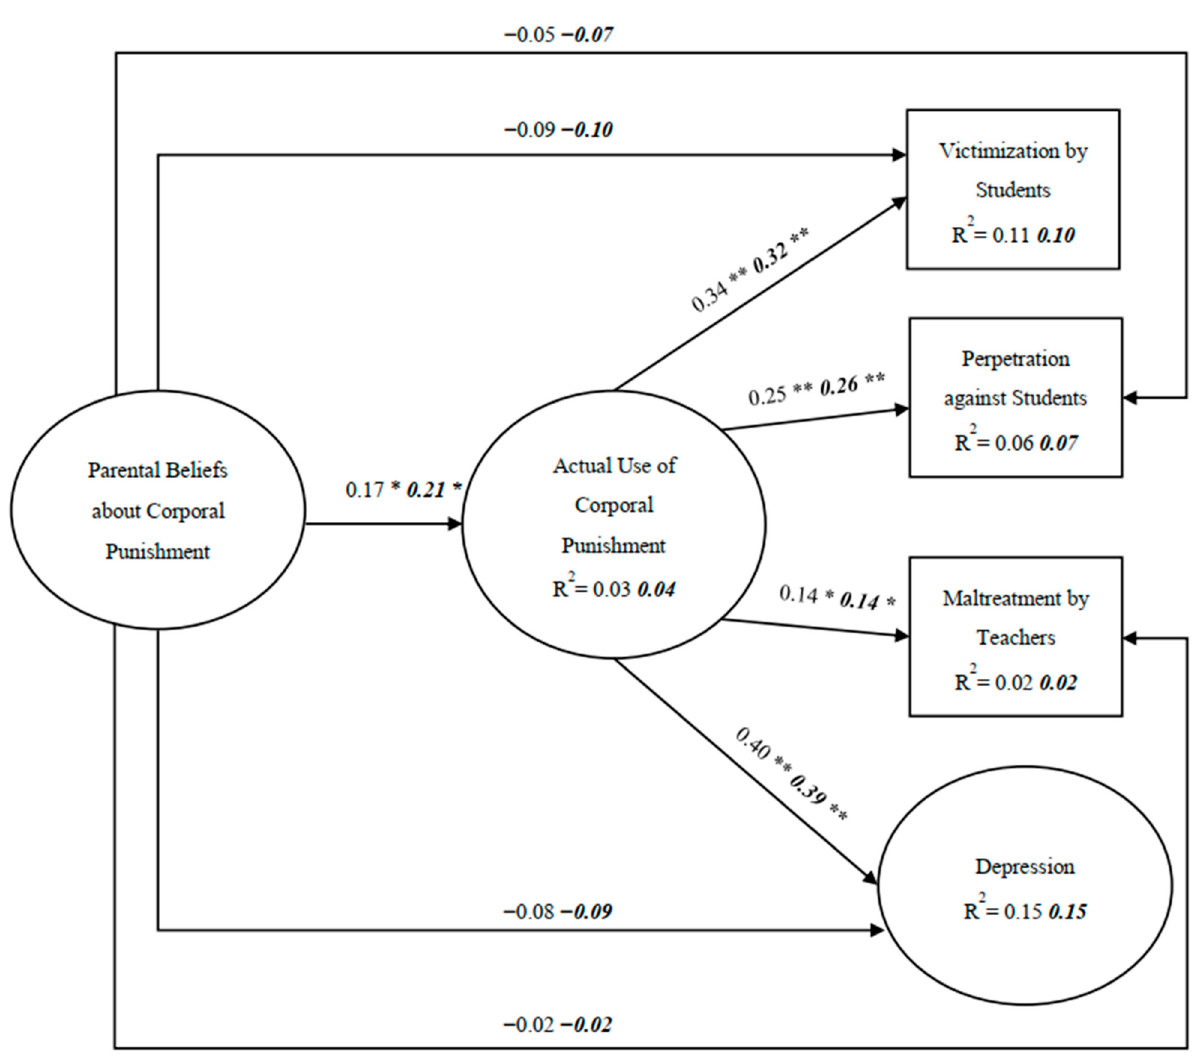
Figure 2. Sex comparison. Note . The coefficients in regular print and those in bold italics represent the results for boy and girl samples, respectively. ** p < 0.001; * p < 0.01.